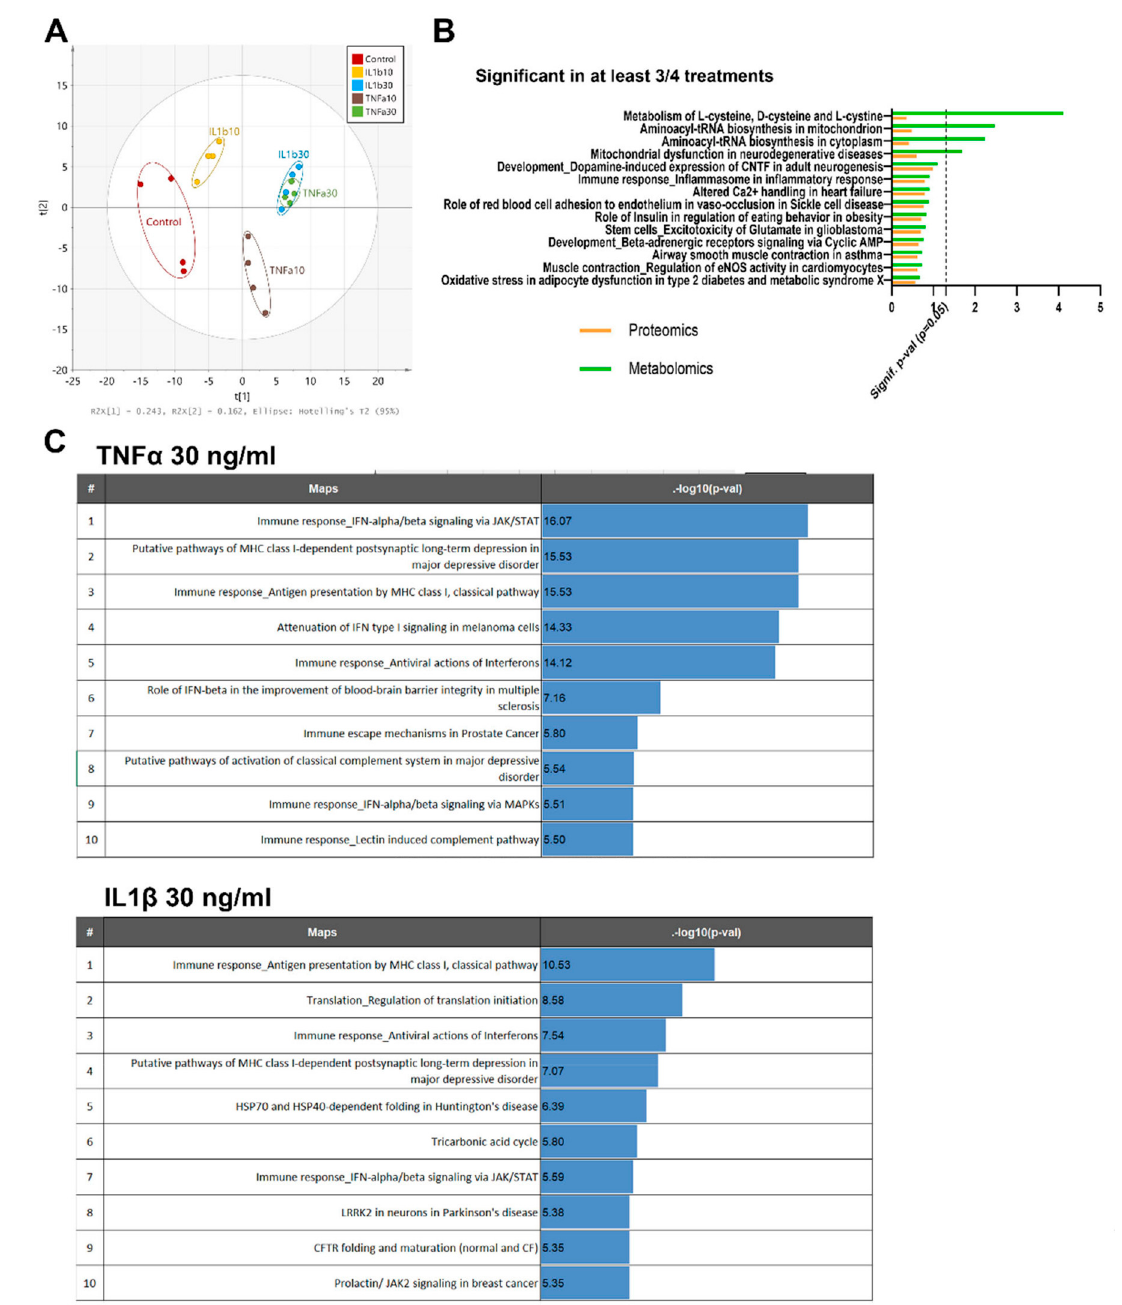
Figure 4. Protein and metabolite pathway analysis after exposure to cytokines. ( A ) PCA of the metabolites measured by three LC–MS approaches, changing after exposure to TNF α or IL1 β (10 and 30 ng/mL) for 24 h. ( B ) Main pathways enriched in at least 3 out of 4 treatments after pathway analysis with MetaCore TM v.6.26 (green: metabolomics, orange: proteomics). ( C ) Top regulated protein pathways found after 24 h of exposure to TNF α (30 ng/mL) or IL1 β (30 ng/mL). Proteins and metabolites with fold change >1.2 or < − 1.2, and a ratio p -value < 0.05 were kept for pathway enrichment